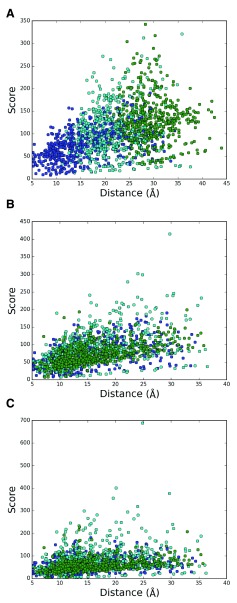
Correlation between score and average distance of a part of the interhelical pairs of bR structures.(
A) set 2, blue, A-B; cyan, A-C; green, A-D. (
B) set 2, blue, A-B; cyan, B-C; green, C-D. (
C) set 1, blue, A-B; cyan, B-C; green, C-D.